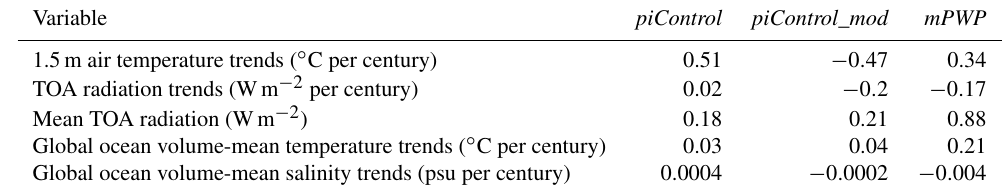
Table 1. Centennial trends (calculated via a linear regression) and climatology over the last 50 years of the simulations. A positive TOA imbalance indicates a net loss of energy from the Earth